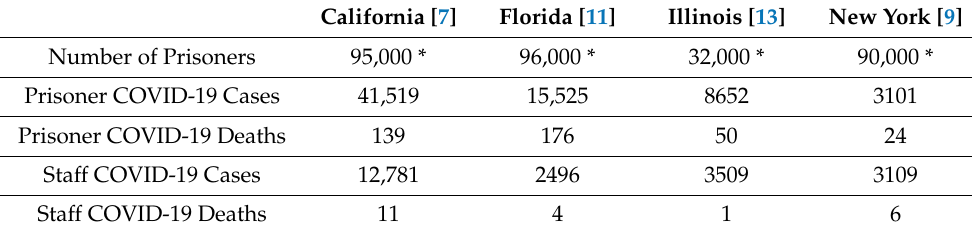
Table 1. COVID-19 in prisons as of 5 January 2021—select